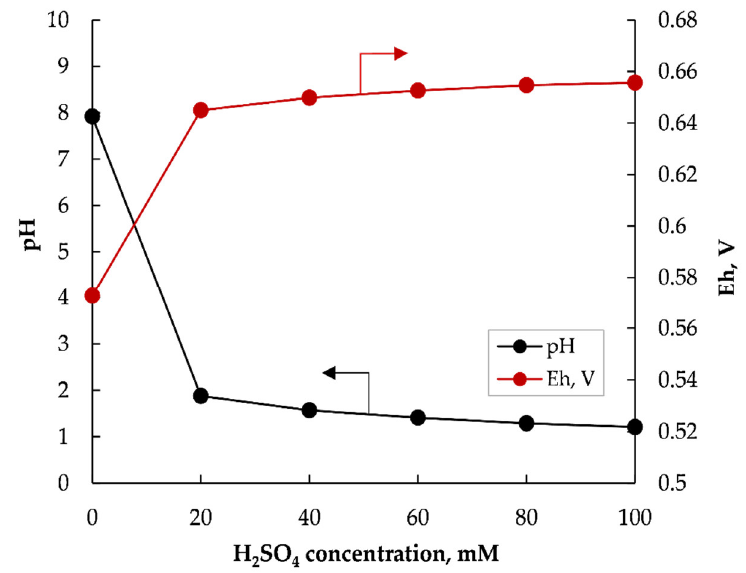
Figure 5. Effect of H 2 SO 4 concentration on pH and Eh in the leaching solution.